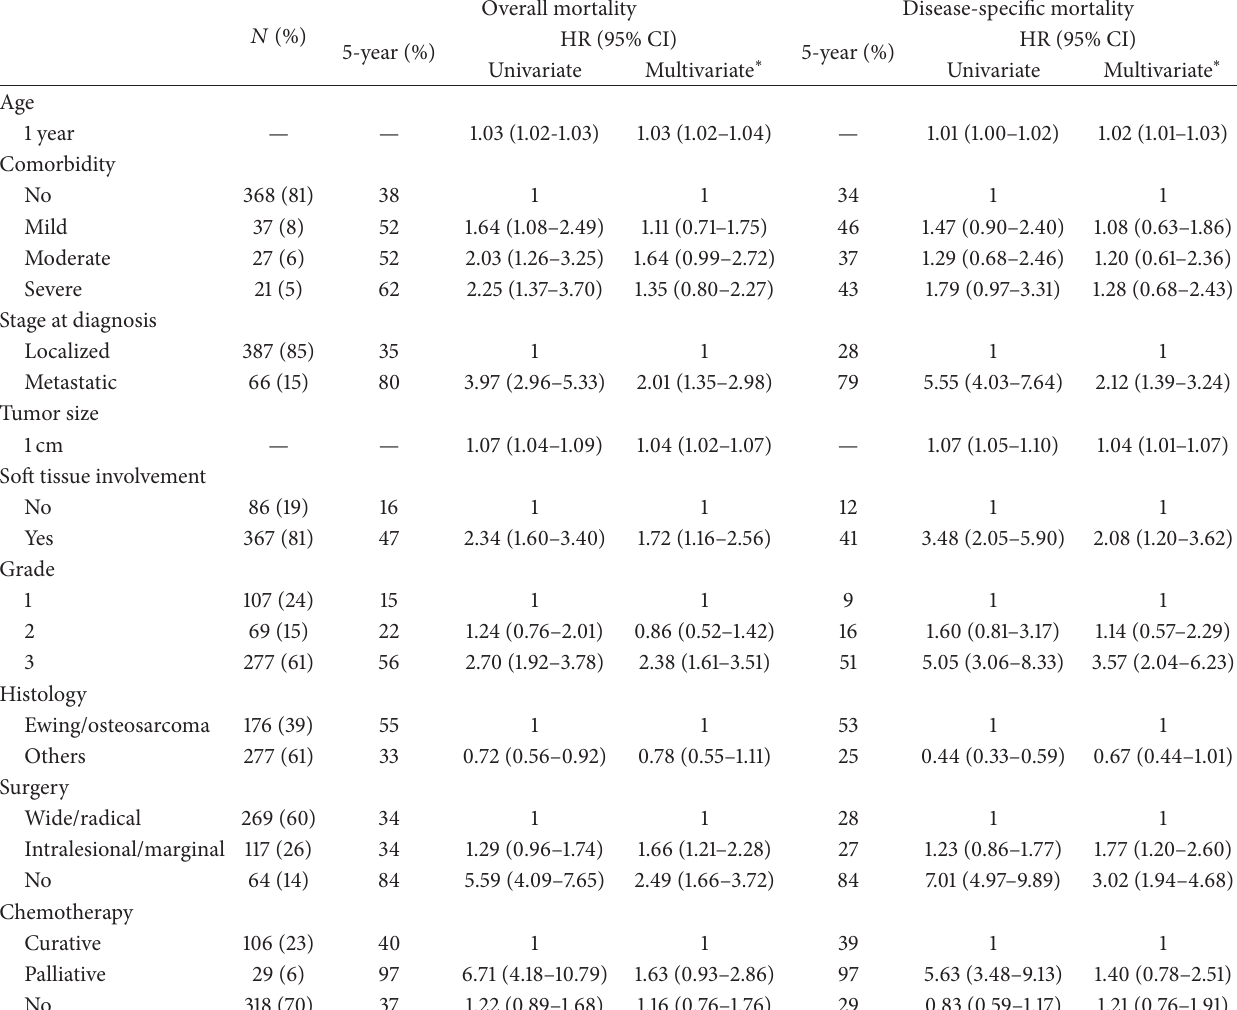
Table 2: Uni- and multivariate analyses of comorbidity and possible important prognostic factors for overall and disease-specific mortality in adult bone sarcoma patients (𝑁 = 453)